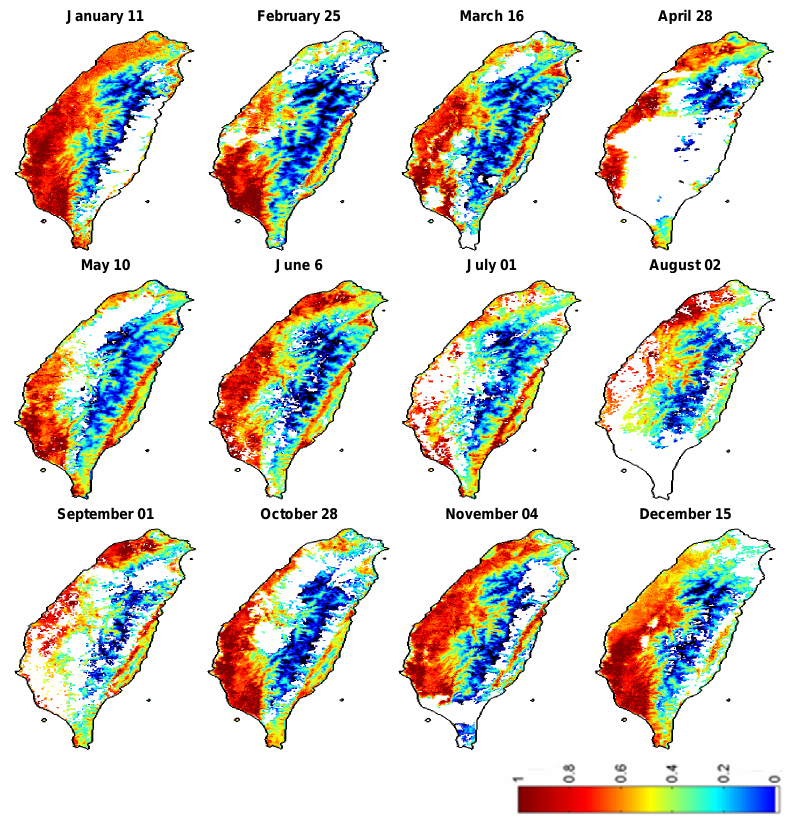
Figure 4. Spatiotemporal evolution of monthly TVDI during